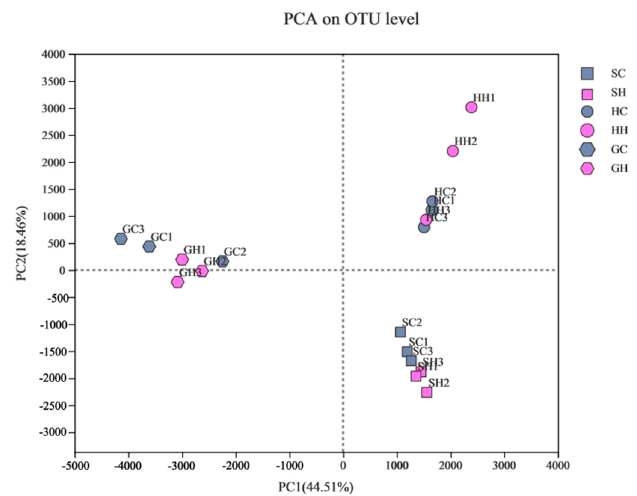
Figure 4. Principal component analysis (PCA) of bacterial communities at the phylum level for all samples. Alkaline soils are represented by triangles; neutral soil samples are represented by squares; acid soil samples are represented by circles, mercury treatments are filled in pink; control treatments are filled in green.